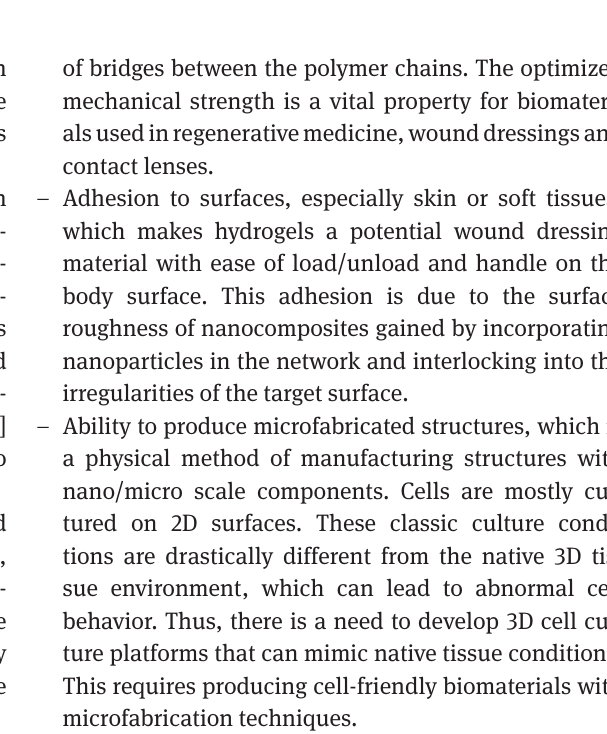
Figure 1: The nanocomposite hydrogels for biomedical applications. Adapted from Ref. [2], Copyright (2013), with permission from John Wiley & Sons,